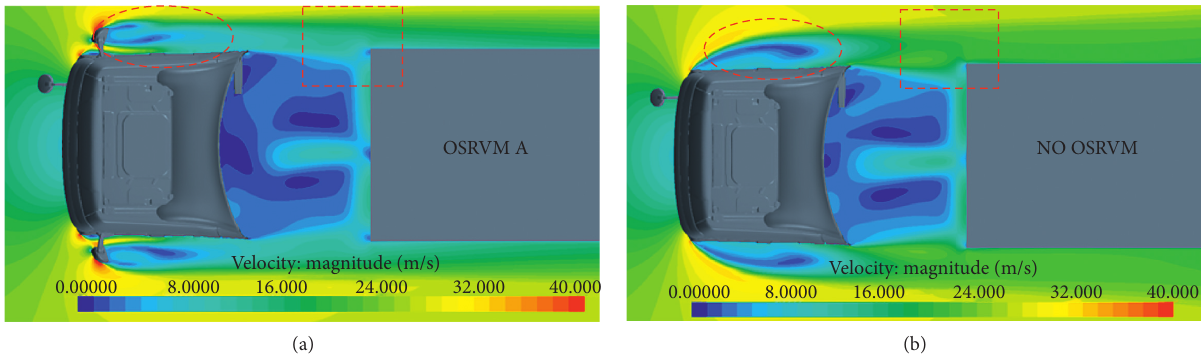
Figure 5: Flow velocity field contour of commercial vehicles with the trailer: (a) with the rear-view mirror; (b) without the rear-view